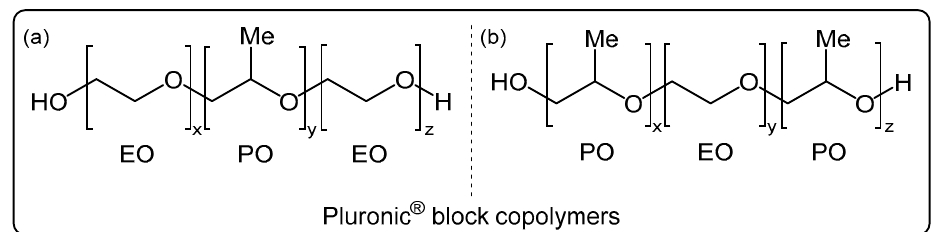
Figure 2. The chemical structure of Pluronic ® triblock copolymer. (PO: Propylene oxide, EO: Ethylene oxide). ( a ) This structure contain Pluronic ® L64, P85, L61, F127, P105 and SP1017, ( b ) This structure contain Pluronic ® 25R2 and